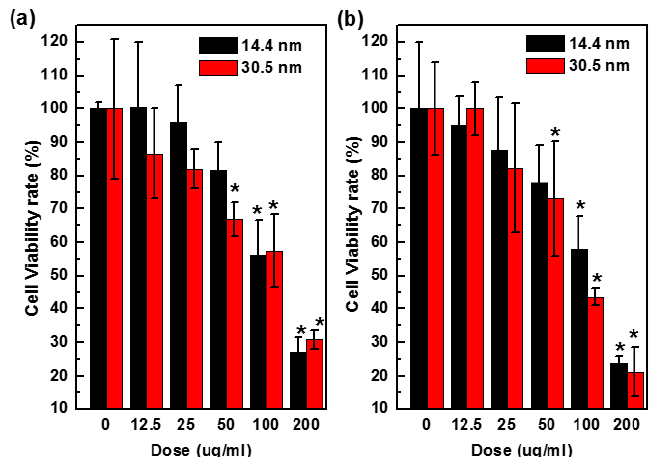
Figure 7. Concentration dependent toxicity in vitro H22 ( a ) and HepG2 cells ( b ) treated with 14.4 or 30.5 nm PEG-coated GNPs after 24 h.